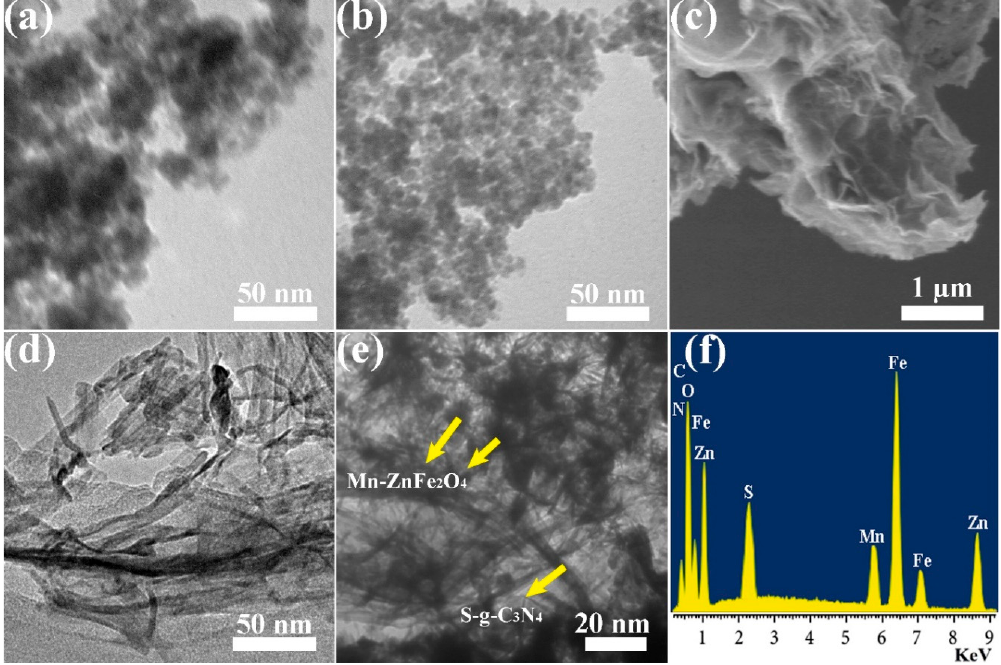
Figure 1. TEM profiles of ( a ) ZnFe 2 O 4 , ( b ) 9% Mn-ZnFe 2 O 4 , ( c ) SEM profile of S-g-C 3 N 4 , ( d ) TEM image of S-g-C 3 N 4, and ( e ) 9% Mn-ZnFe 2 O 4 /50% S-g-C 3 N 4 NCs. ( f ) EDX of 9% Mn-ZnFe 2 O 4 /50% S-g-C 3 N 4 NCs.